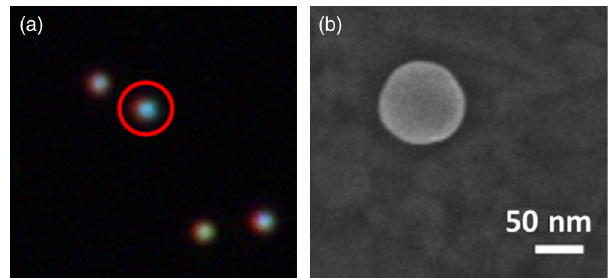
FIG. 12. (a) Dark-field optical image of a gold film with 80-nm gold nanoparticles deposited on top. (b) SEM image of the single particle highlighted in